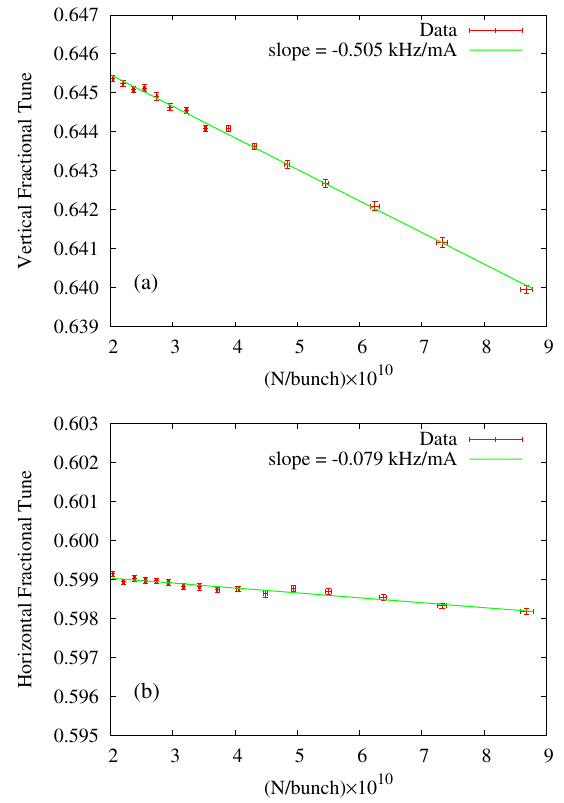
FIG. 6. Fractional coherent tune versus current for (a) the vertical and (b) the horizontal plane. The resolution of the measurement is 10 (cid:1) 4 . The revolution frequency is 390.1